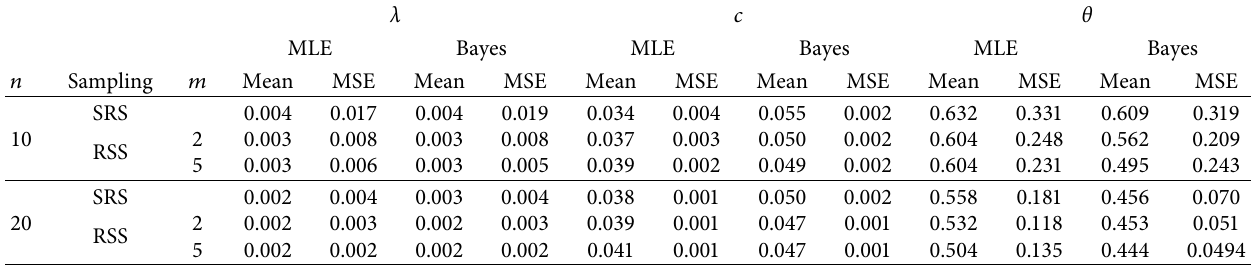
and 􏽢 θ for the real data example. MLE BAY